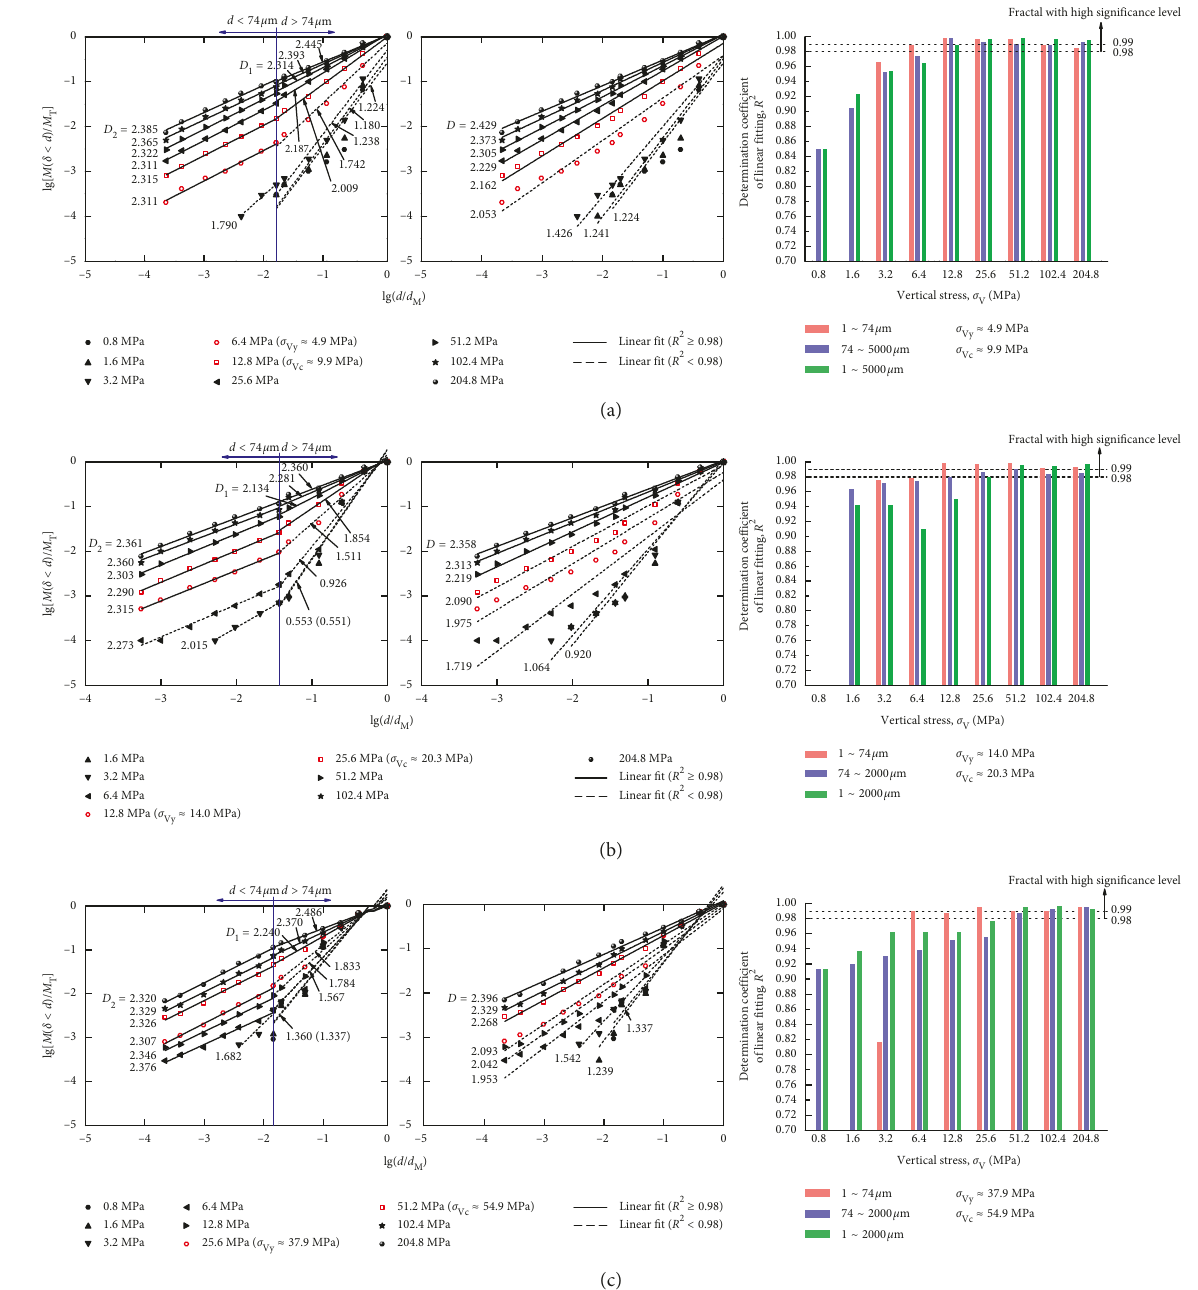
Figure 6: Linear fitting between lg[ M ( δ < d )/ M T ] and lg( d / d M ) with the left picture regarding particle size finer than 74 μ m and coarser than 74 μ m as a fitting range, respectively, with the middle picture regarding the whole measurable particle size interval as the only fitting range, and with the right picture expressing the histograms of determination coefficients R 2 of these three linear fittings at each preset vertical stress level for (a) QS1, (b) QS2, and (c)